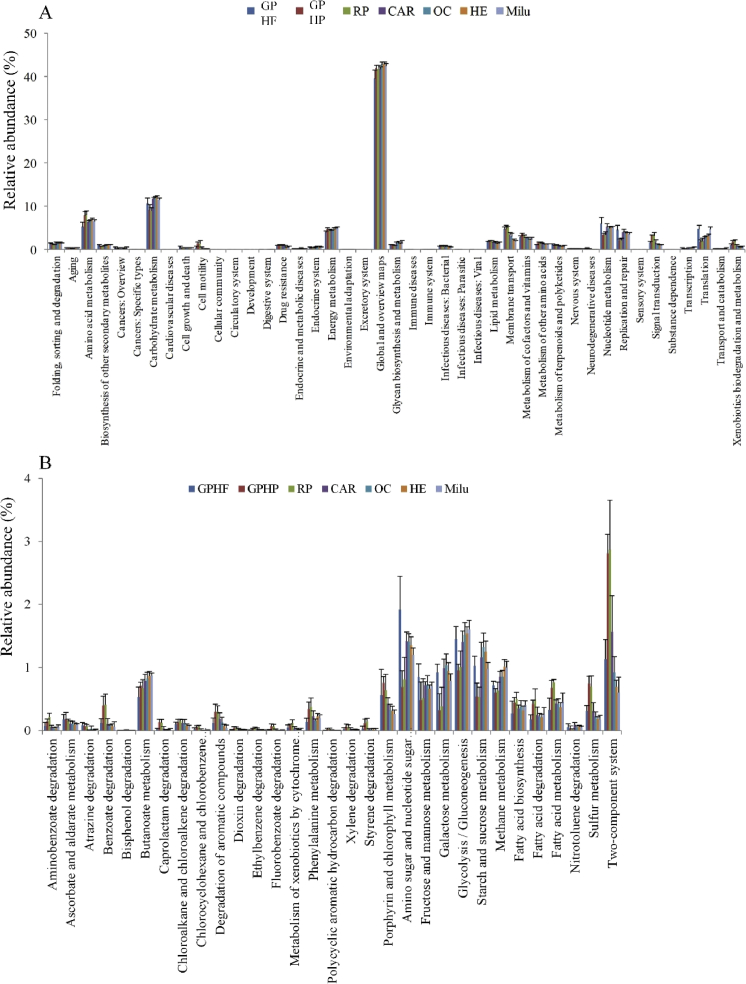
Metagenomic analysis of gut microbial communities from giant pandas, red pandas, and other mammals. (A) Significantly different (ANOVA, p < 0.05) relative abundances of KEGG level 2 pathways among 94 gut bacterial metagenomes (including 19 from giant pandas, 6 from red pandas, 30 from Milu (Père David's deer), and 39 other mammalian gut microbiome metagenomes (Muegge et al., 2011)). (B) Enrichment of metabolic pathways related to xenobiotic biodegradation and metabolism, amino acid metabolism, metabolism of cofactors and vitamins and lipid metabolism in GP-HP and red pandas. RP, red pandas; CAR, carnivorous mammals; OC, omnivorous mammals; HE, herbivorous mammals. Milu, Père David's deer.